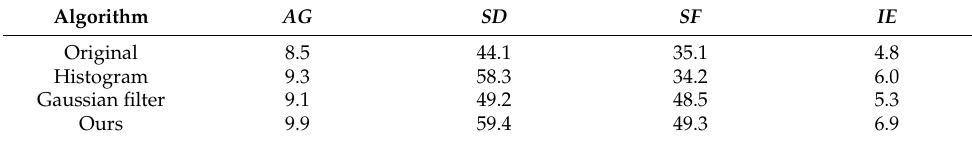
Table 2. Long coastline image quality.